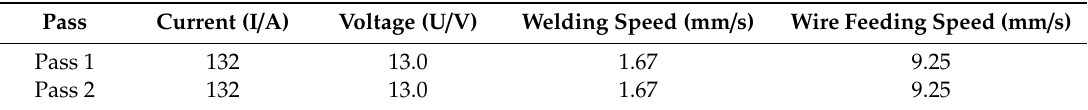
Table 2. Welding parameters.